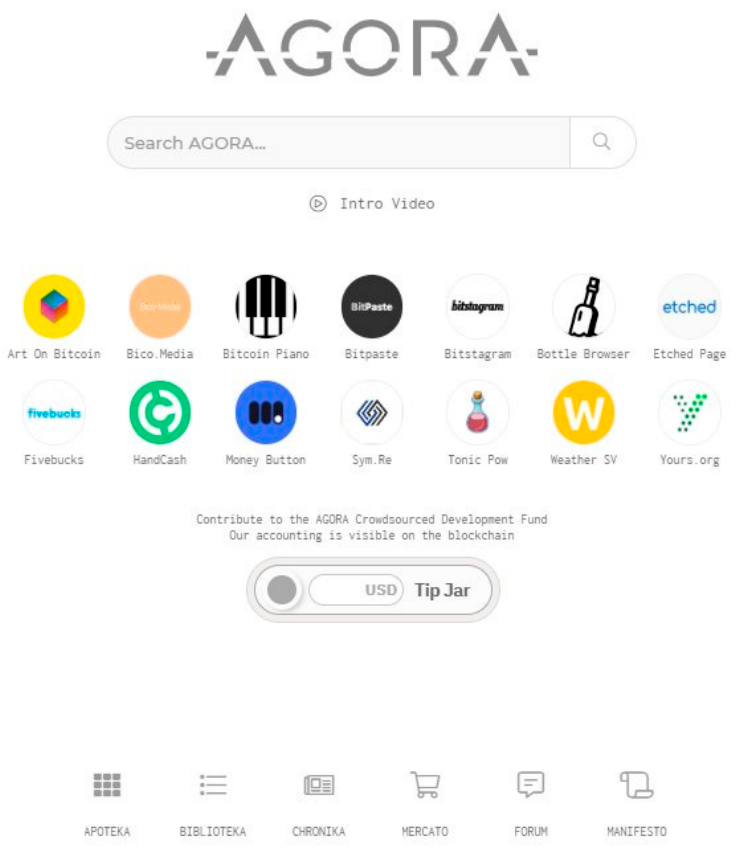
Figure 4. Agora, the homepage for Metanet [33].